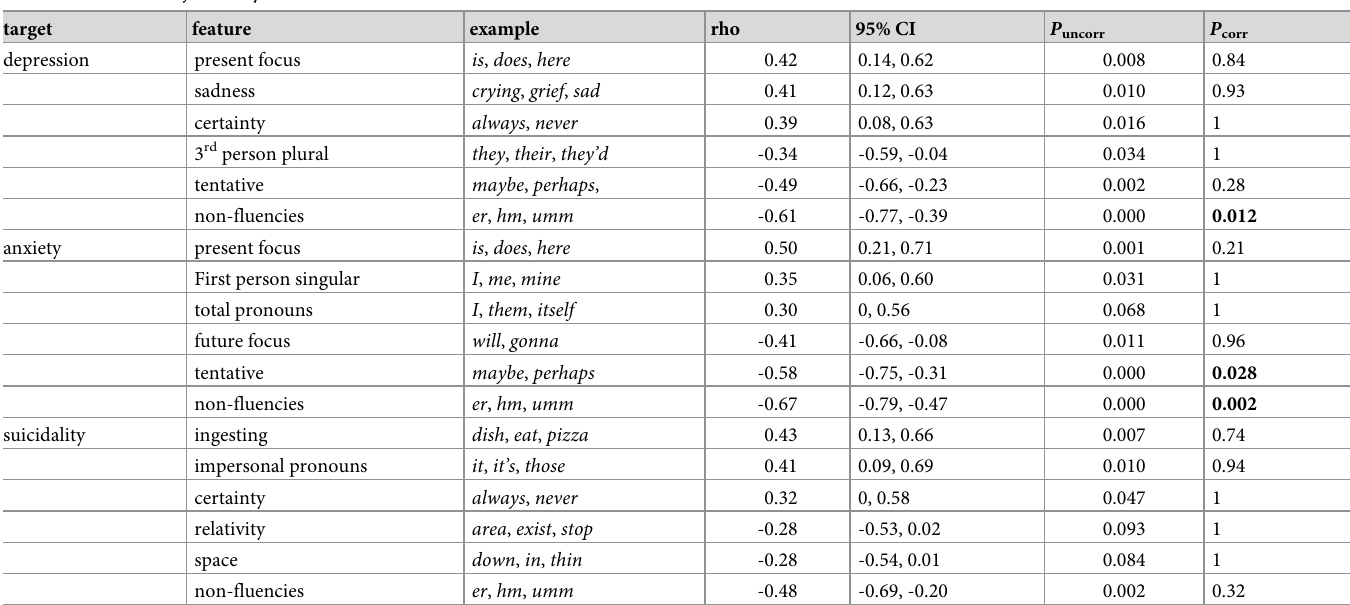
Table 3. Between-subject